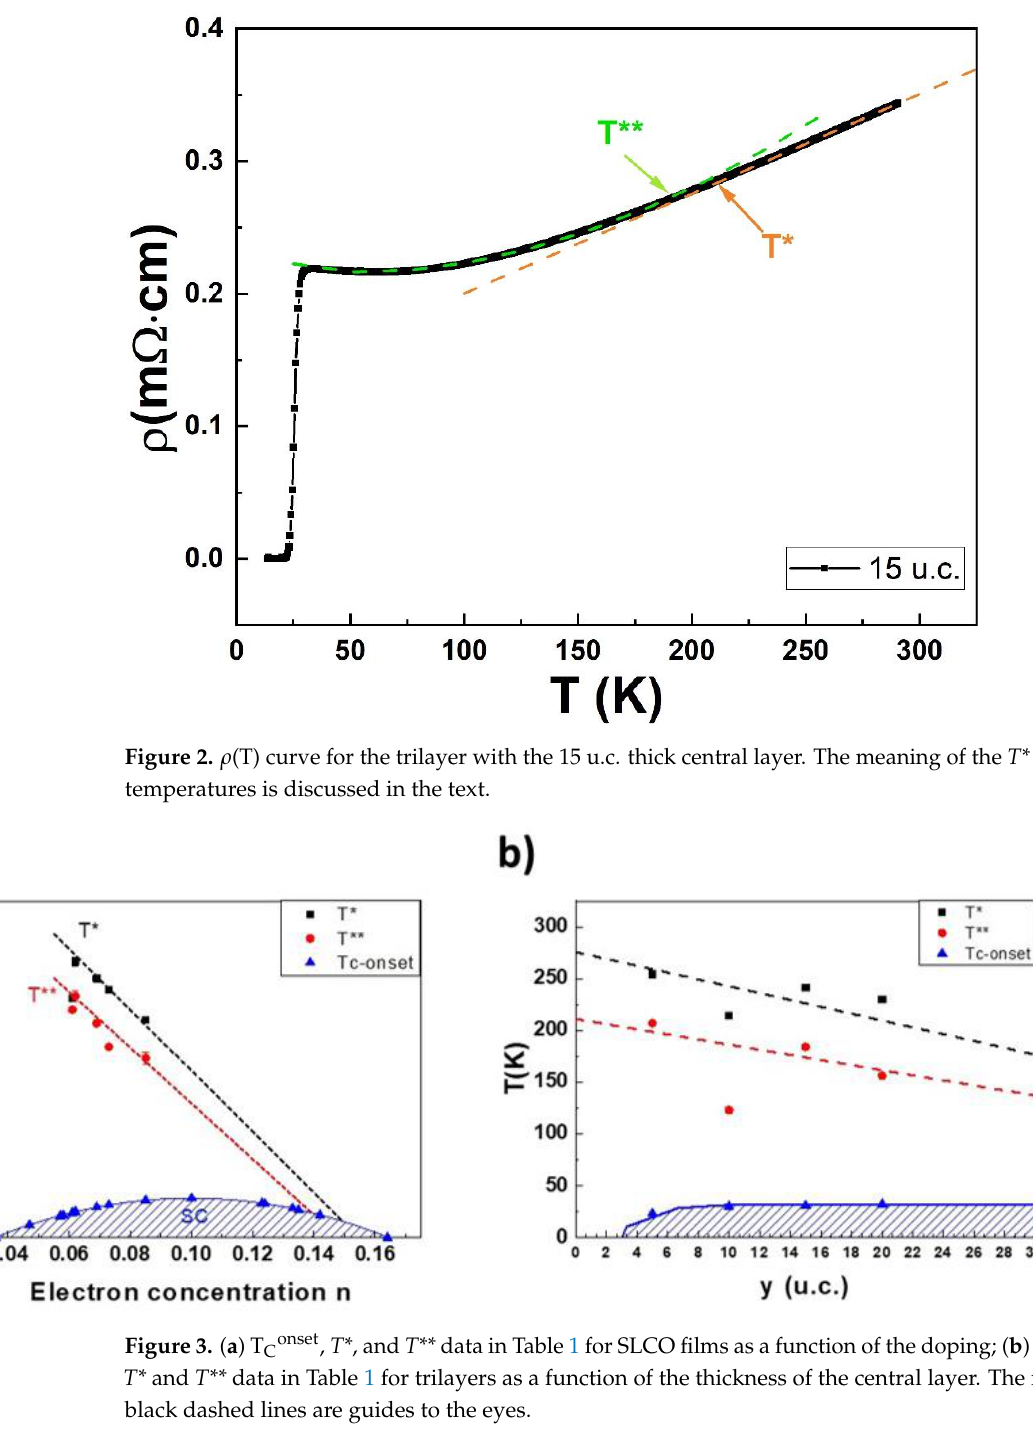
Figure 3. ( a ) T Conset , T*, and T** data in Table 1 for SLCO films as a function of the doping; ( b ) T Conset , T* and T** data in Table 1 for trilayers as a function of the thickness of the central layer. The red and black dashed lines are guides to the eyes.